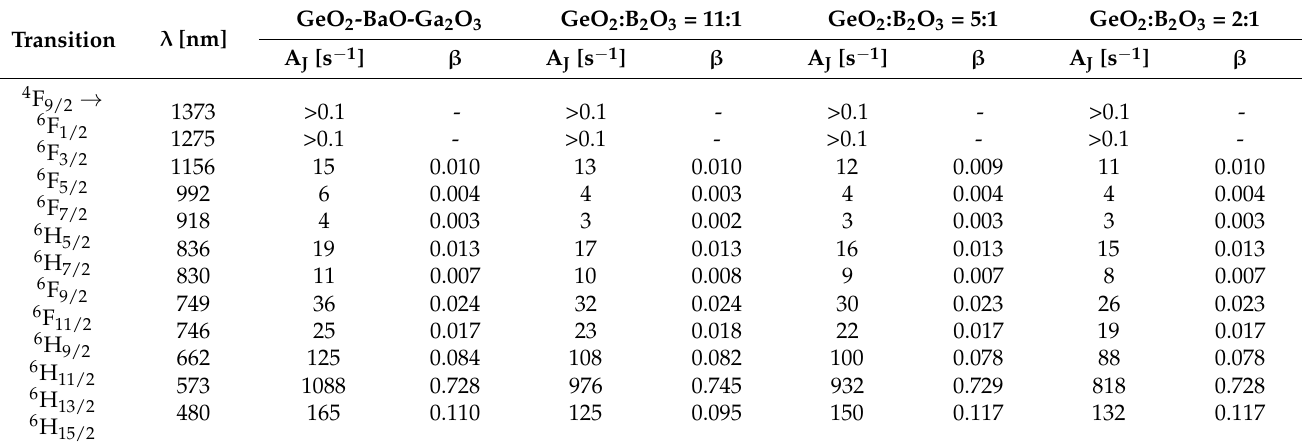
Table 6. The radiative transition probabilities and luminescence branching ratios for Dy 3+ ions in